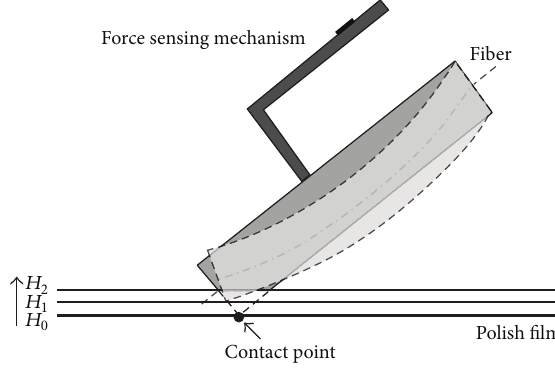
Figure 1: The force sensing mechanism [3].